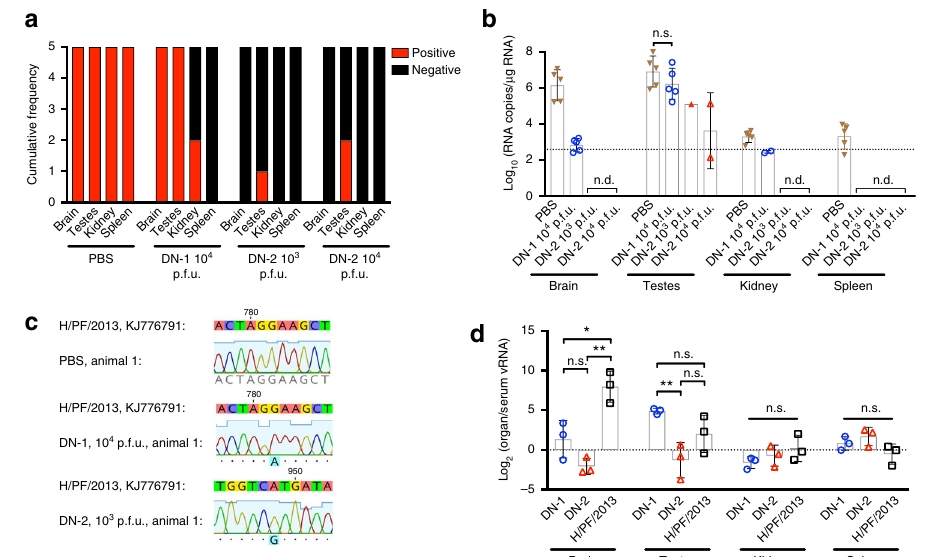
Fig. 8 DN-2 demonstrates decreased organ infection. a Frequency of viral RNA detection and b levels of viral RNA detected in the brains, testes, kidneys, and spleens using at 15 days post challenge or at killing for animal study in Fig. 5. c Sequence of viral RNA detected in testes samples were determined using Sanger sequencing to distinguish identity of virus. d Male mice ( n = 3 per group) were infected with 10 4 p.f.u. of DN-1, DN-2 and H/PF/2013 i.p., killed at 8 days post infection and viral loads in the brains, testes, kidneys, and spleens were quanti fi ed using qPCR with normalization against viremia. Error bars represent s.d. * p < 0.05, ** p < 0.01 in unpaired t test. Dotted lines on viral quanti fi cation graphs represent limit of detection or when y -value = 0 in normalized values. n.s. not signi fi cant, n.d. not